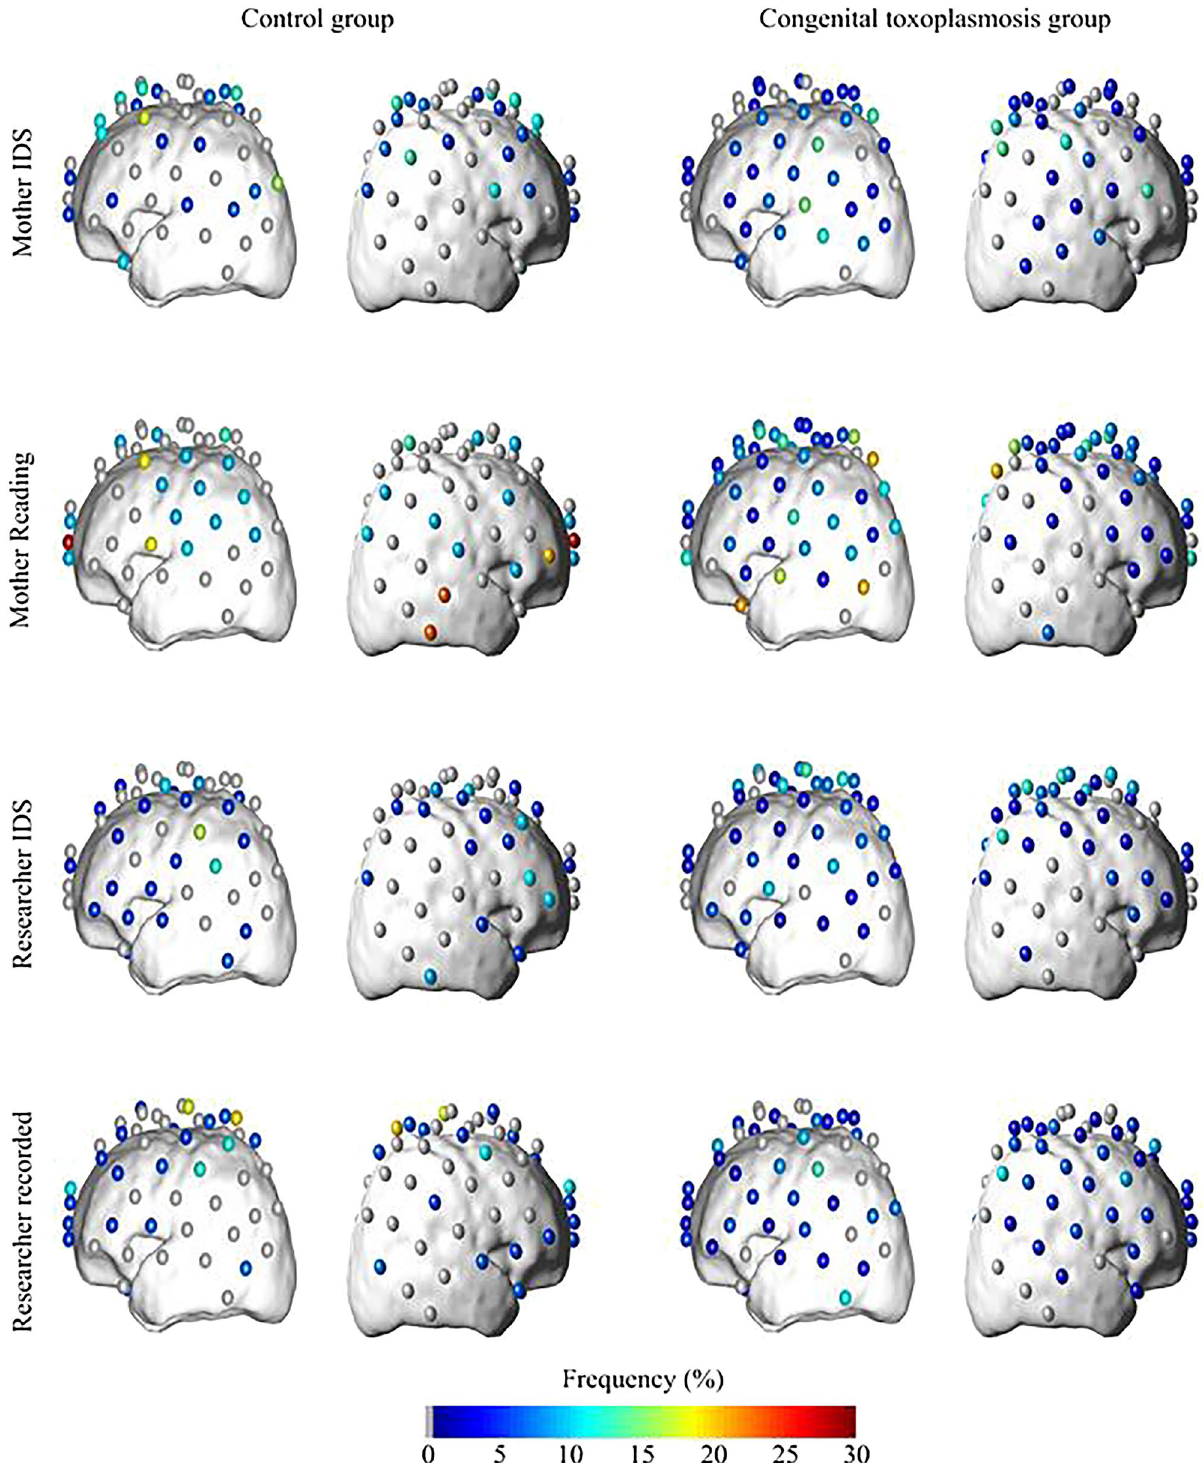
Figure 3. Frequency of deactivated channels in control group for: mother infant directed speech (IDS) n = 16; mother reading n = 10; researcher infant directed speech n = 17; researcher recorded n = 16; and in Congenital toxoplasmosis group for: mother infant directed speech n = 24; mother reading n = 23; researcher infant directed speech n = 27; researcher recorded n =